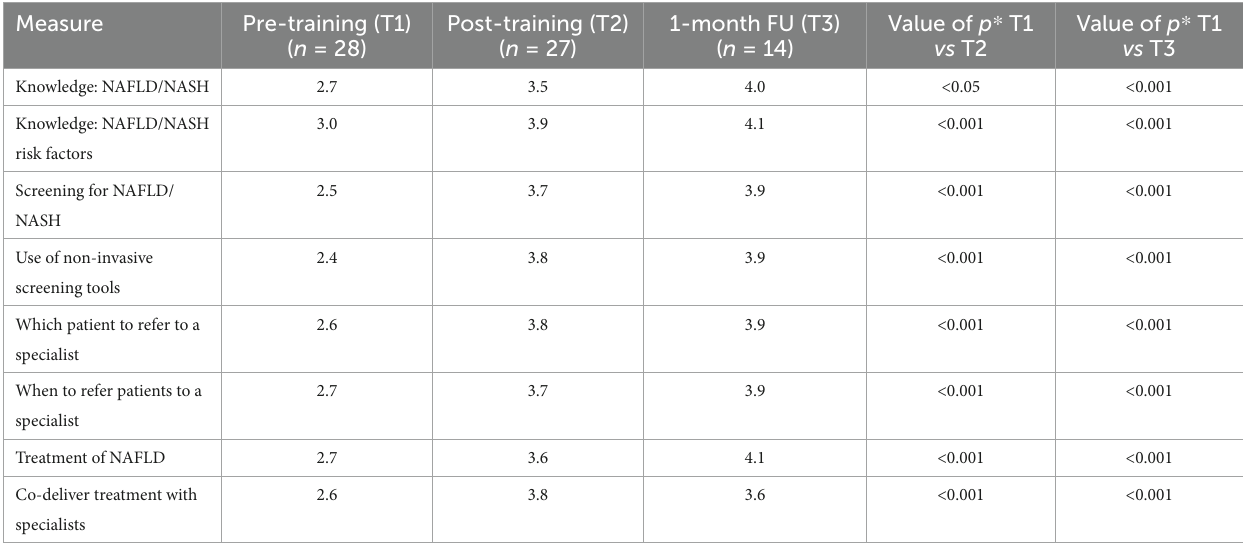
TABLE 3 Changes in NAFLD/NASH-related confidence pre- and post-training and 1-month following exposure to the CME intervention among primary care providers who participated in the feasibility